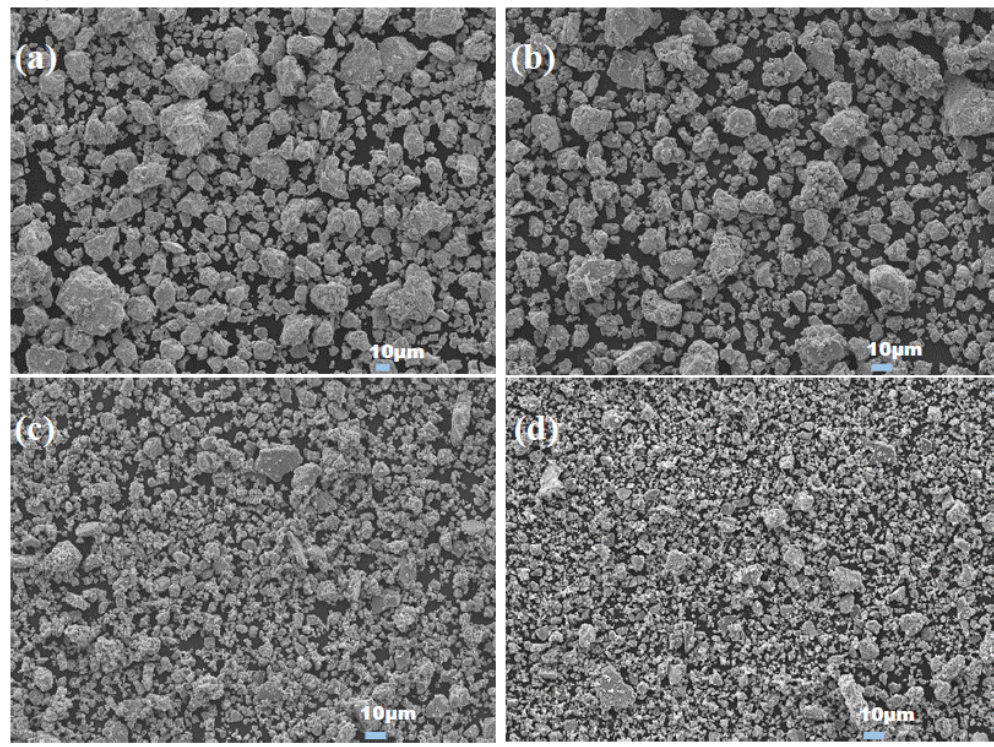
Figure 1. Morphology of the milled TiC–Cu powders ( a ) 20 vol % TiC, nanocomposite A; ( b ) 20 vol % TiC, nanocomposite B; ( c ) 30 vol % TiC, nanocomposite A; and ( d ) 30 vol % TiC, nanocomposite B (SEM images).